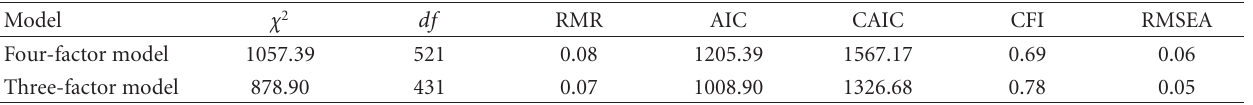
Table 4: Fit indices for the two models.